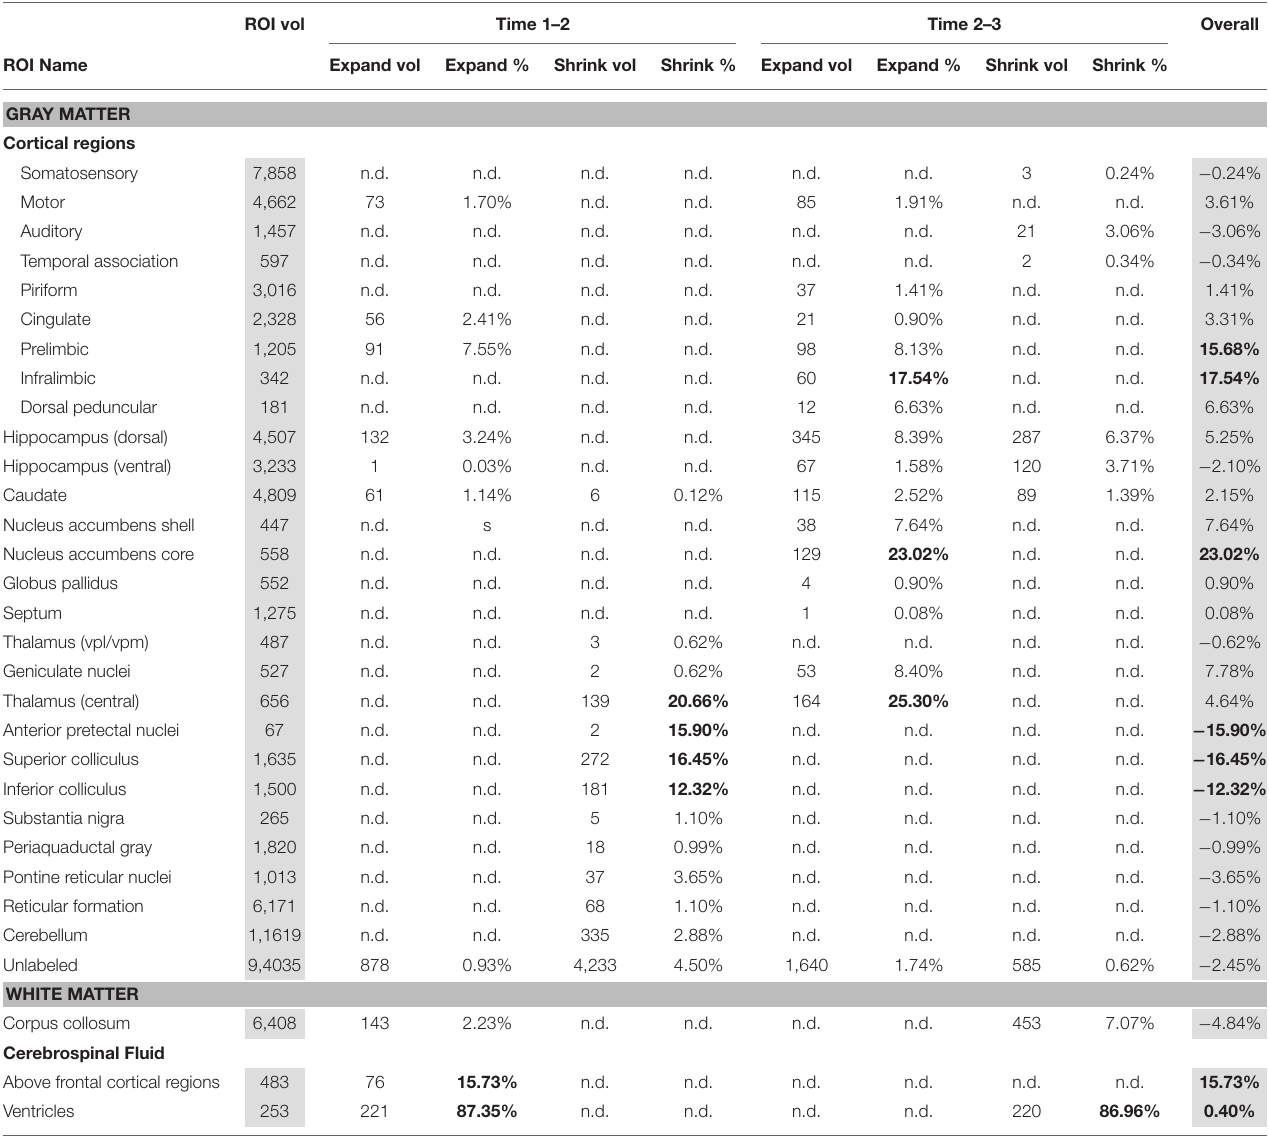
TABLE 1 | Between group analysis using PW atlas. ROI vol Time